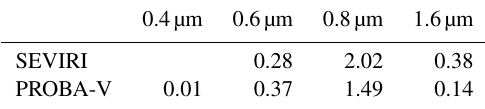
Table 5. Total EQMPN median values (%). Table 6. FASTRE relative uncertainty in the SEVIRI and PROBA-V processed bands